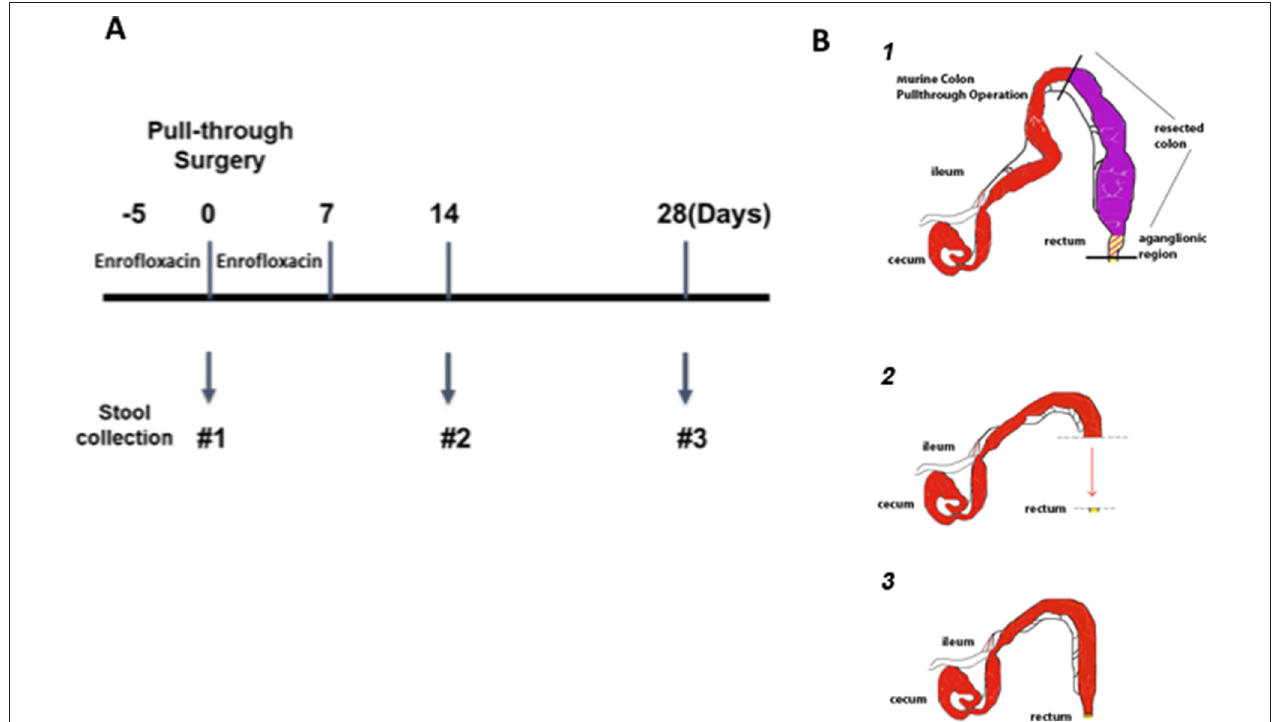
Figure 1 | Experimental design and microsurgical pull-through operation. (a) The timeline for antibiotic administration, pull-through surgery and stool sample collection. Animals were given enrofloxacin drinking water for 5 days before pull-through surgery and continued for 7 days after surgery. The stool samples were collected at the time of surgery (#1), 14 days (#2), and 28 days (#3) post-surgery for those animals. (B) The steps of the microsurgical pull-through operation, demonstrating the (1) resection of the aganglionic region, (2) advancement of the normal colon and (3) anastomosis to the distal